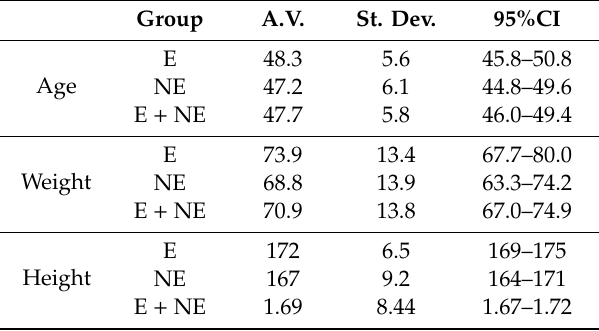
Table 2. Statistical analysis for all the subjects of the study. E = exposed, NE = non exposed, 95%CI = Confidence Interval at 95%. Age (years), weight (kg), height (cm), average value (A.V.) and standard deviations (St.